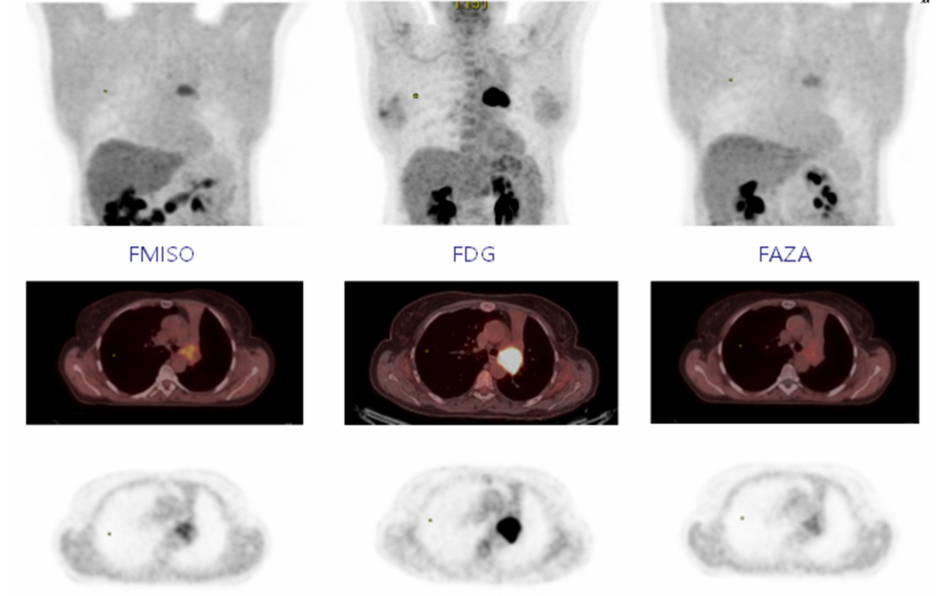
Figure 1. Fixing FMISO, FDG, and FAZA on MIP, axial PET-CT, and axial PET. The SUVmax FMISO was greater than SUVmax FAZA ( p = 0.0003) (Figure 2a). The ratio between the SUVmax FMISO and FAZA of the lesion was 1.39 ( ± 0.33), and the ratio for the SUVmean mediastinum (FMISO/FAZA) was 1.14 ( ± 0.12). At a threshold of 1.4; the FMISO volume was greater than the FAZA volume ( p = 0.004) (Figure 2b), and the ratio of the volume was 6.41 ( ± 13.61). For a threshold at 1.5* SUVmean mediastinum, the ratio was 4.84 ( ±